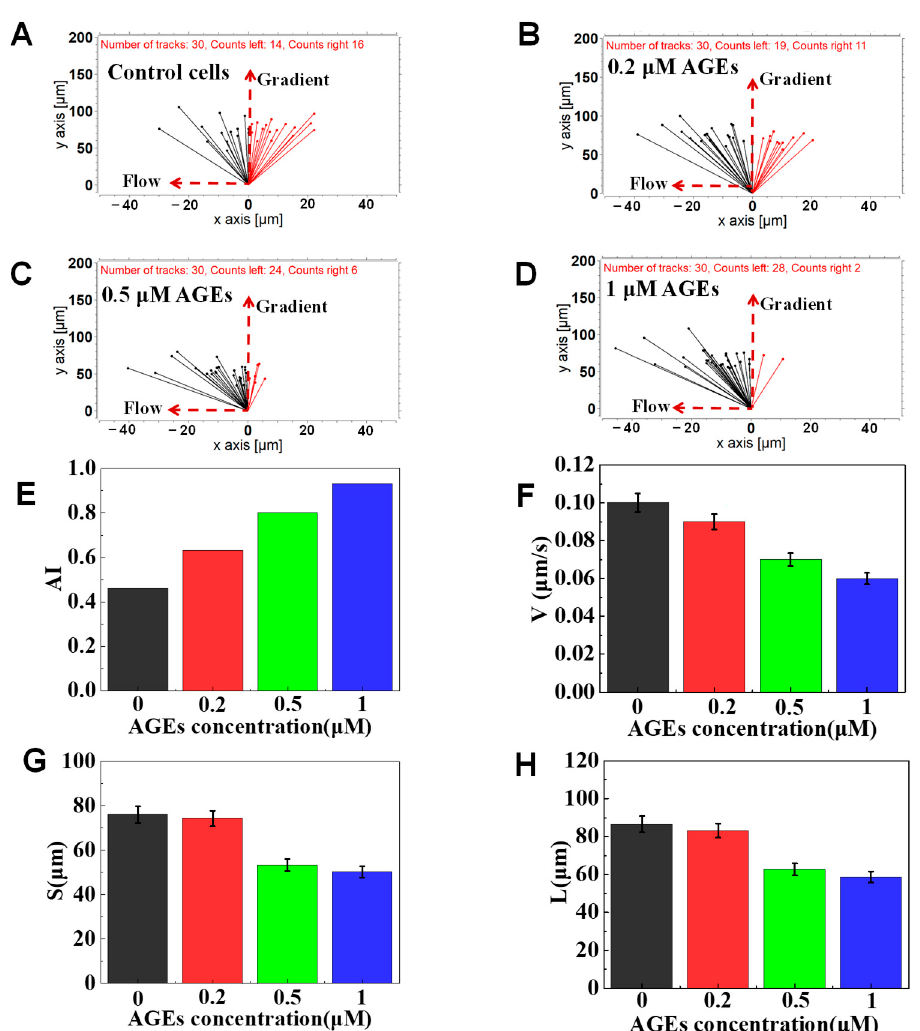
Figure 7. Chemotaxis of AGEs-treated cells in 100 nM of fMLP gradient. ( A ) The connecting line between the initial position and the end position of cells pretreated with 0 µ M AGEs. ( B ) The connecting line between the initial position and the end position of cells pretreated with 0.2 µ M AGEs. ( C ) The connecting line between the initial position and the end position of cells pre-treated with 0.5 μ M AGEs. ( D ) The connecting line between the initial position and the end position of cells pretreated with 1 μ M AGEs. ( E – H ) Comparison of quantitative cell migration parameters including drifting index (AI), cell velocity (V), the displacement along the gradient (S), and the whole movement distance (L).